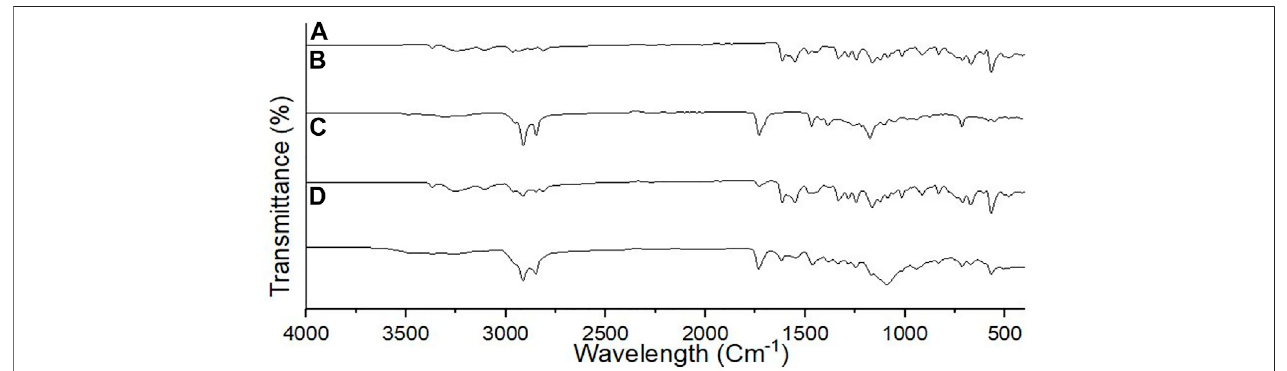
FIGURE 4 | Powder X-ray diffraction pattern of (A) PGZ, (B) Compritol 888 ATO, (C) poloxamer 188, and (D) optimized PGZ-NLCs.